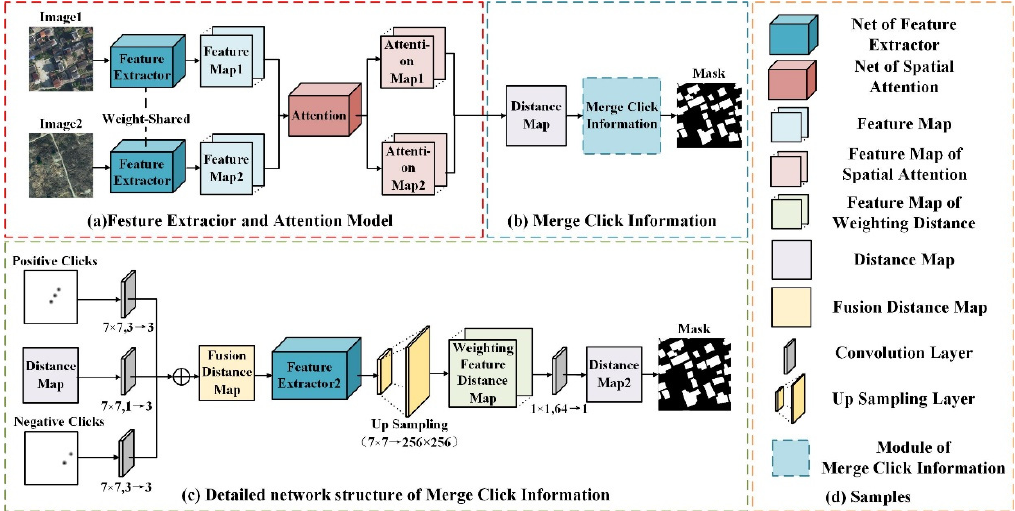
Figure 2. ICD network structure.